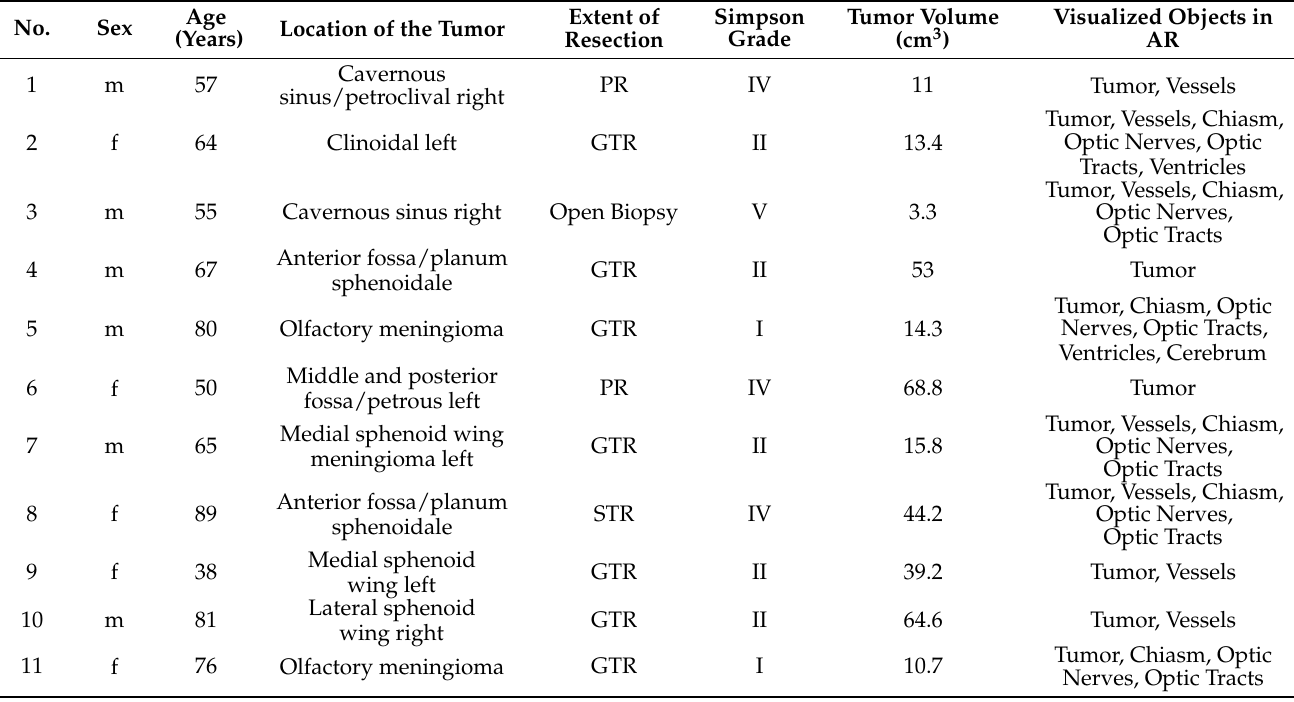
Table 1. General characteristics of the